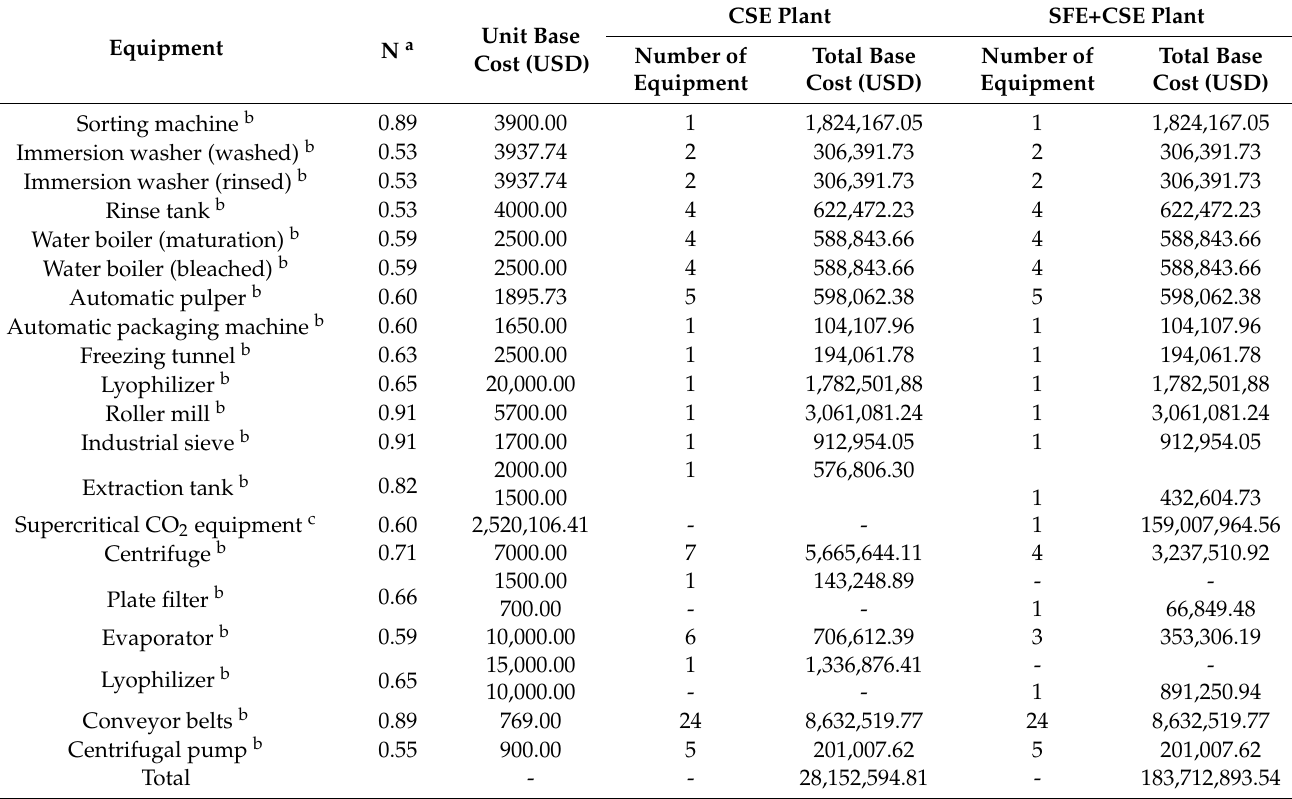
Table 3. Base costs for each equipment composing the extraction